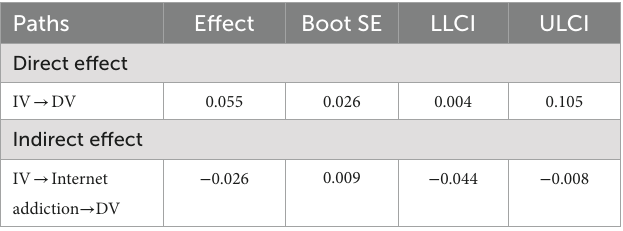
TABLE 4 Non-standardized mediation analysis results. Paths